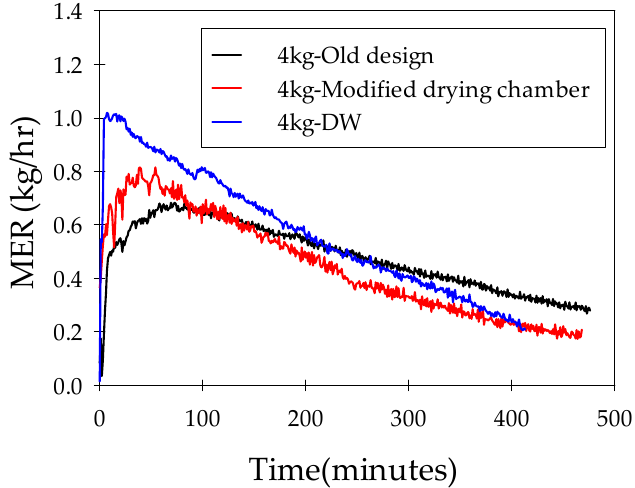
Figure 13. Moisture extraction rate versus drying time for the minimum test load.